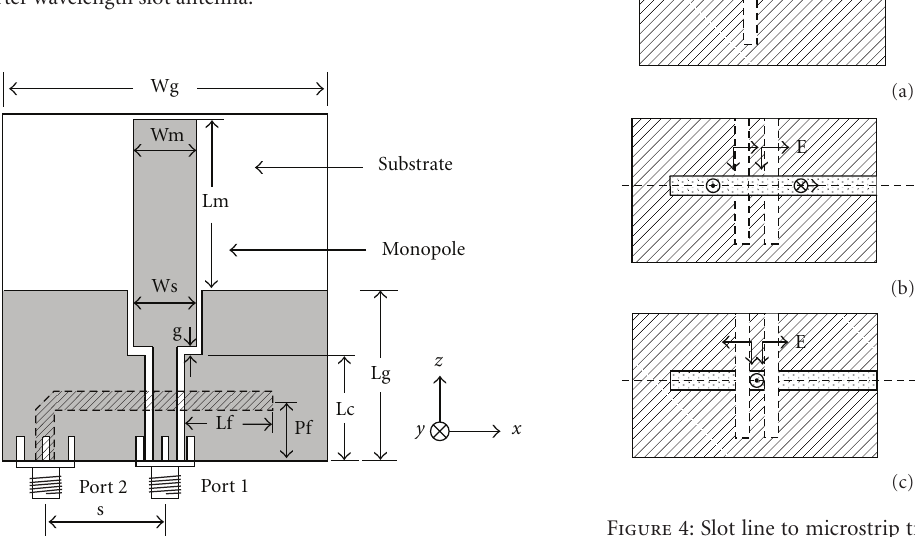
Figure 1: The current distribution of printed monopole and quarter wavelength slot antenna.